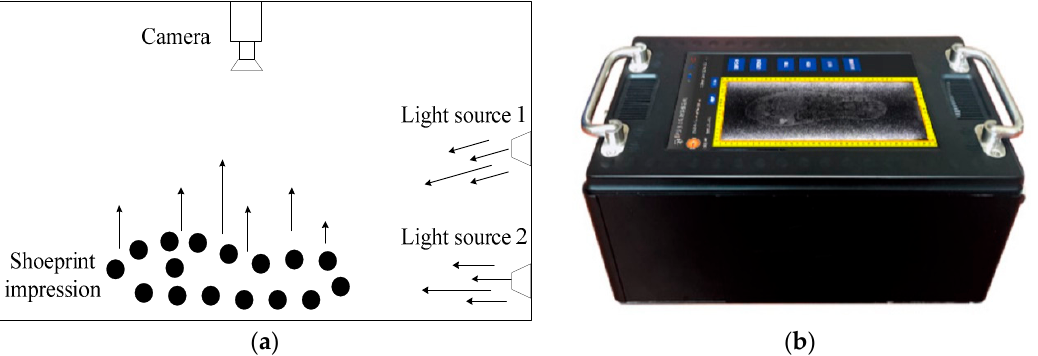
Figure 3. Illustration of the crime scene shoeprint scanner. ( a ) Structural diagram of the crime scene shoeprint scanner; ( b ) the real system of the crime scene shoeprint scanner.